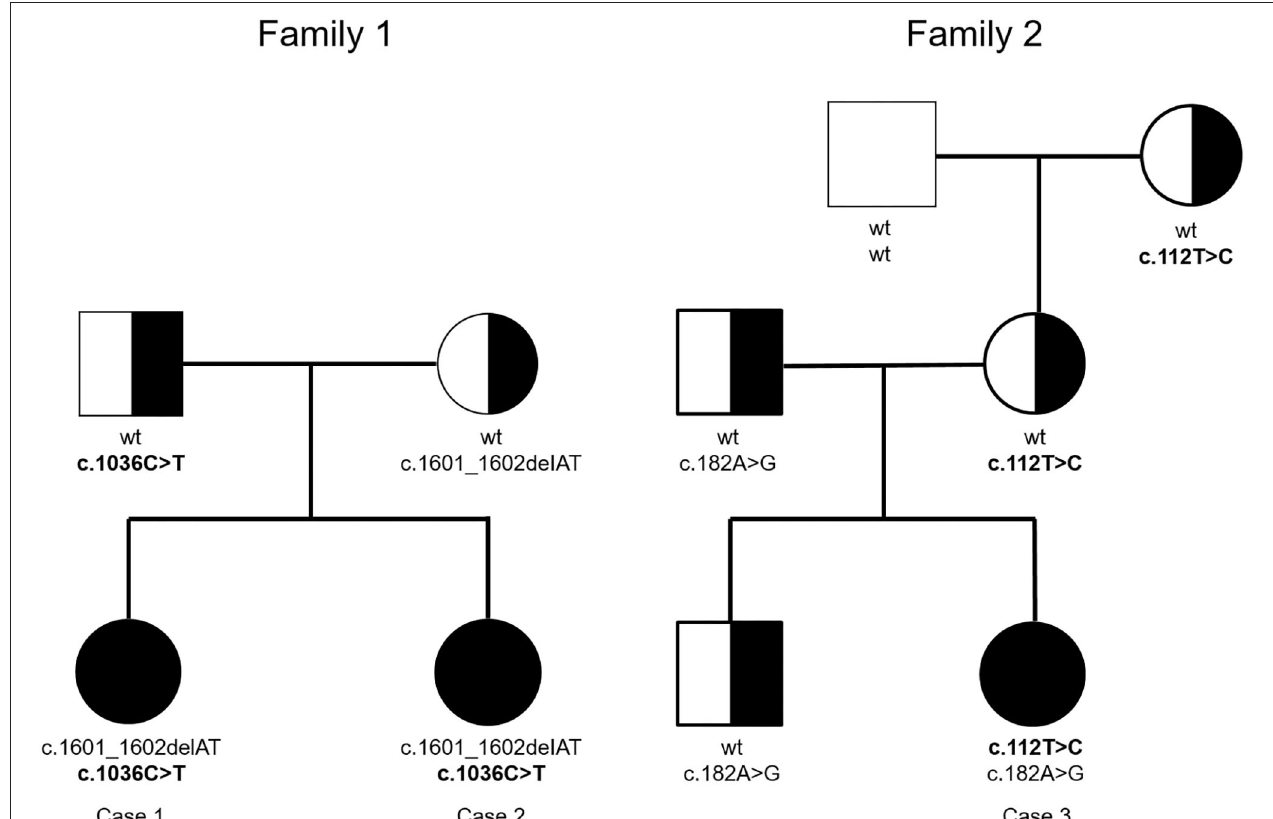
FIGURE 1 | Pedigrees of the two BSS families (novel mutations depicted in